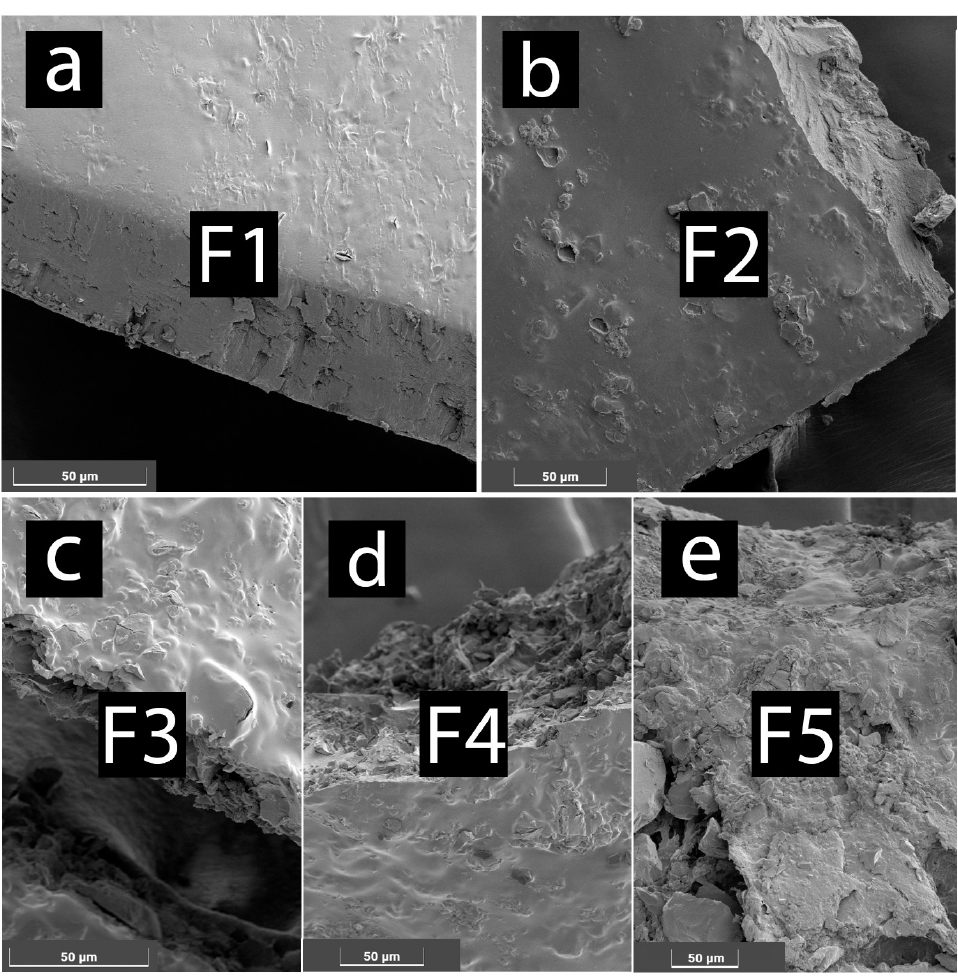
Figure 2. SEM images showing surface morphology of freeze-dried nanogels: ( a ) F1, ( b ) F2, ( c ) F3, ( d ) F4, and ( e ) F5.